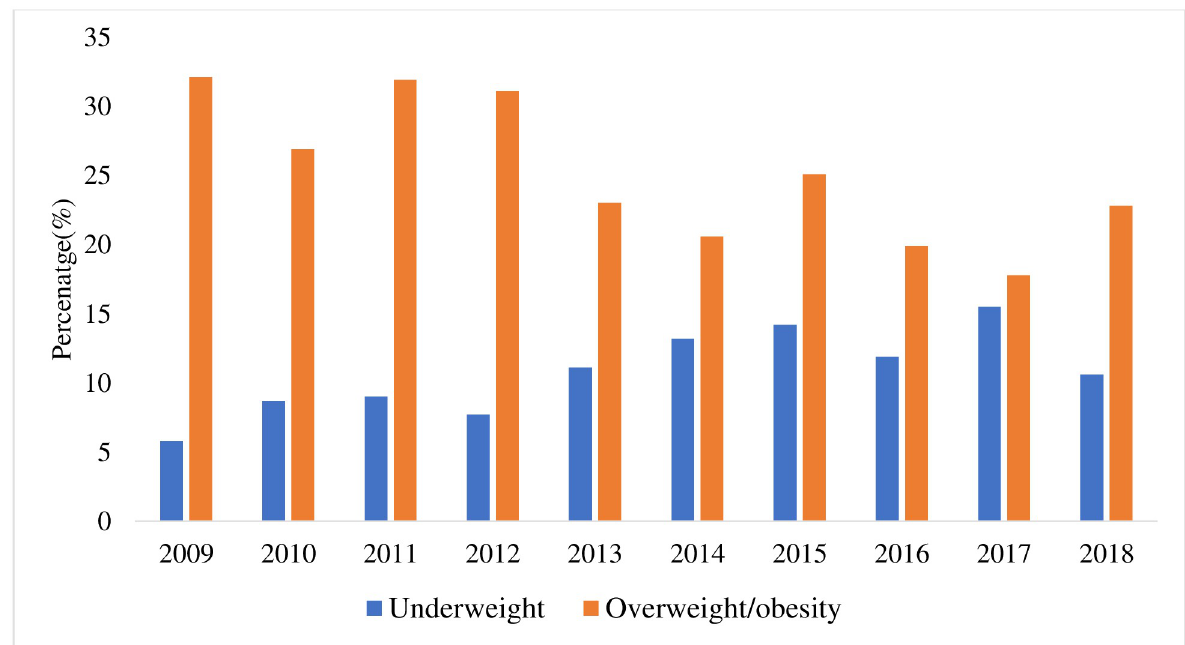
Fig 1. Trends in the prevalence of underweight and overweight/obesity (overnutrition) across each year of admission between 2009 and 2018.